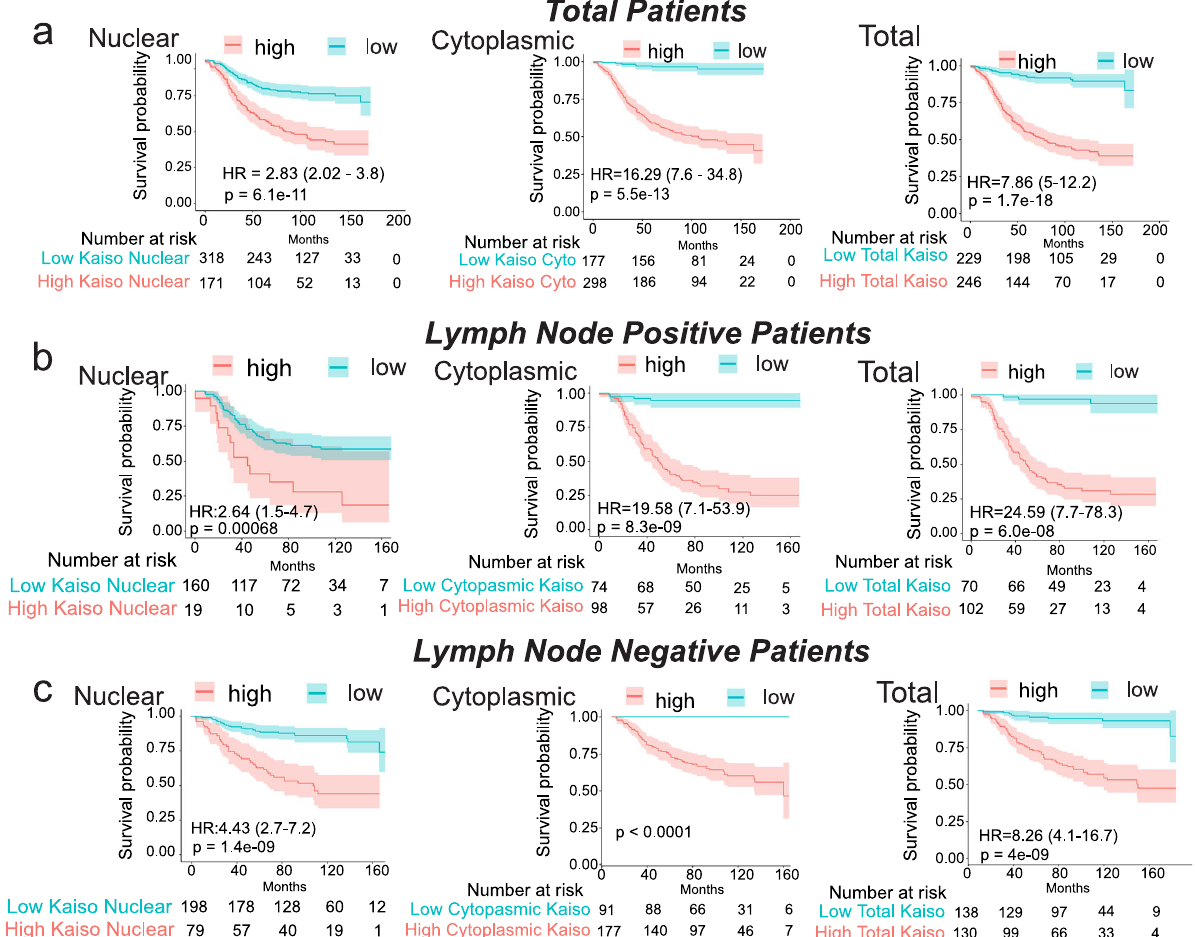
Fig. 2 Both nuclear Kaiso and cytoplasmic Kaiso are predictive of poor breast cancer survival. a Analysis of the association between subcellular Kaiso distribution and survival demonstrates that high cytoplasmic Kaiso is much more predictive of poor survival compared to nuclear Kaiso. Nuclear, cytoplasmic, and total Kaiso H -scores predict survival in both b high risk (lymph node-positive) and c low risk (lymph node-negative) breast cancer patients, where total Kaiso score is most predictive of survival in both low and high-risk breast cancer patients. (HR could not be calculated for cytoplasmic Kaiso in low-risk patients because no deaths were recorded in that risk group). NHW non-Hispanic white; NHB non-Hispanic black. Optimized cut-offs were determined by the method of maximally selected rank statistics (Supplementary Fig. 3 and Supplementary Table 2). Table 1 Univariate and multivariate analysis of the hazard ratio for overall survival associated with patient demographics, subtype, nuclear Kaiso, cytoplasmic Kaiso, and cytoplasmic LC3A/B expression in patient breast cancer samples. Univariate